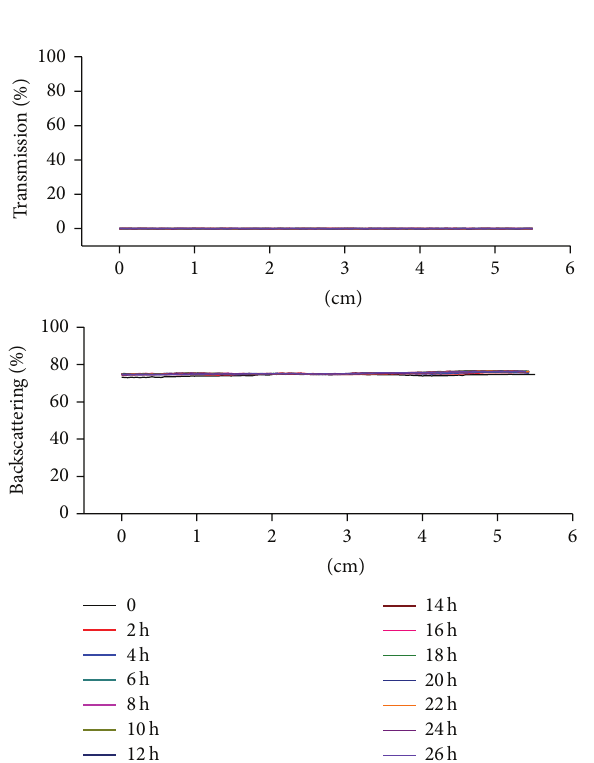
Figure 8: Result of dispersion stability of drilling fluid.